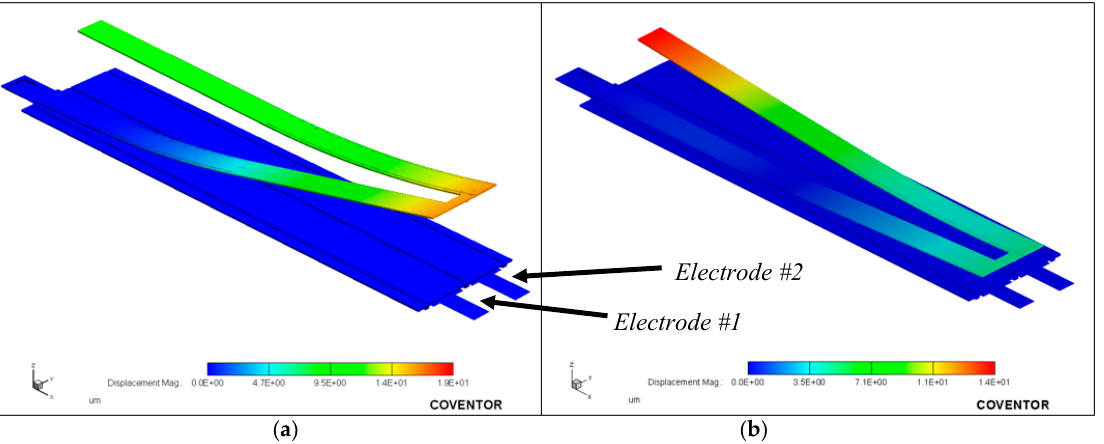
Figure 4. This figure shows the displacement results for a two-segment, 500 micron zipper beam when a voltage is applied to electrode #1; ( a ) shows the 0 V condition and ( b ) shows when 24 V is applied. Data was calculated using Coventorware ® software under license to Air Force Institute of